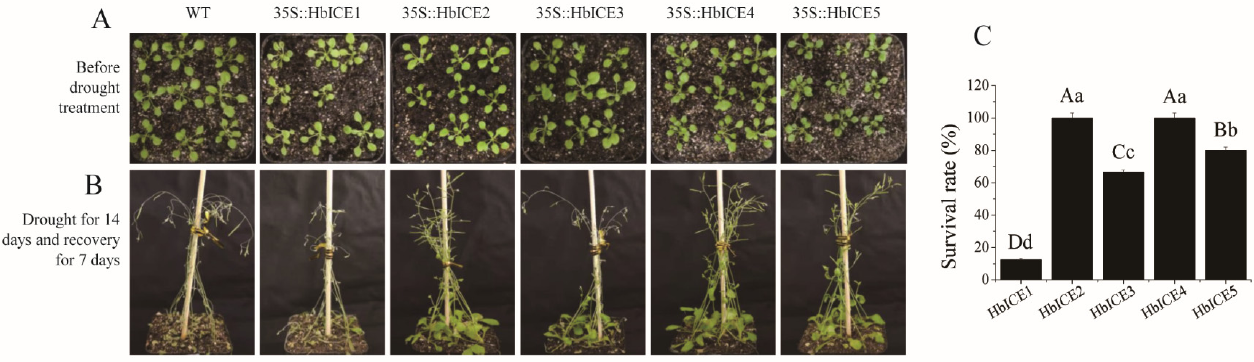
Figure 5. Effect of overexpression of HbICEs on drought tolerance in Arabidopsis . ( A , B ). The phe- notypes of WT and transgenic plants before drought treatment ( A ) and after drought followed by recovery ( B ). ( C ) Survival ratio of transgenic plants after drought treatment.